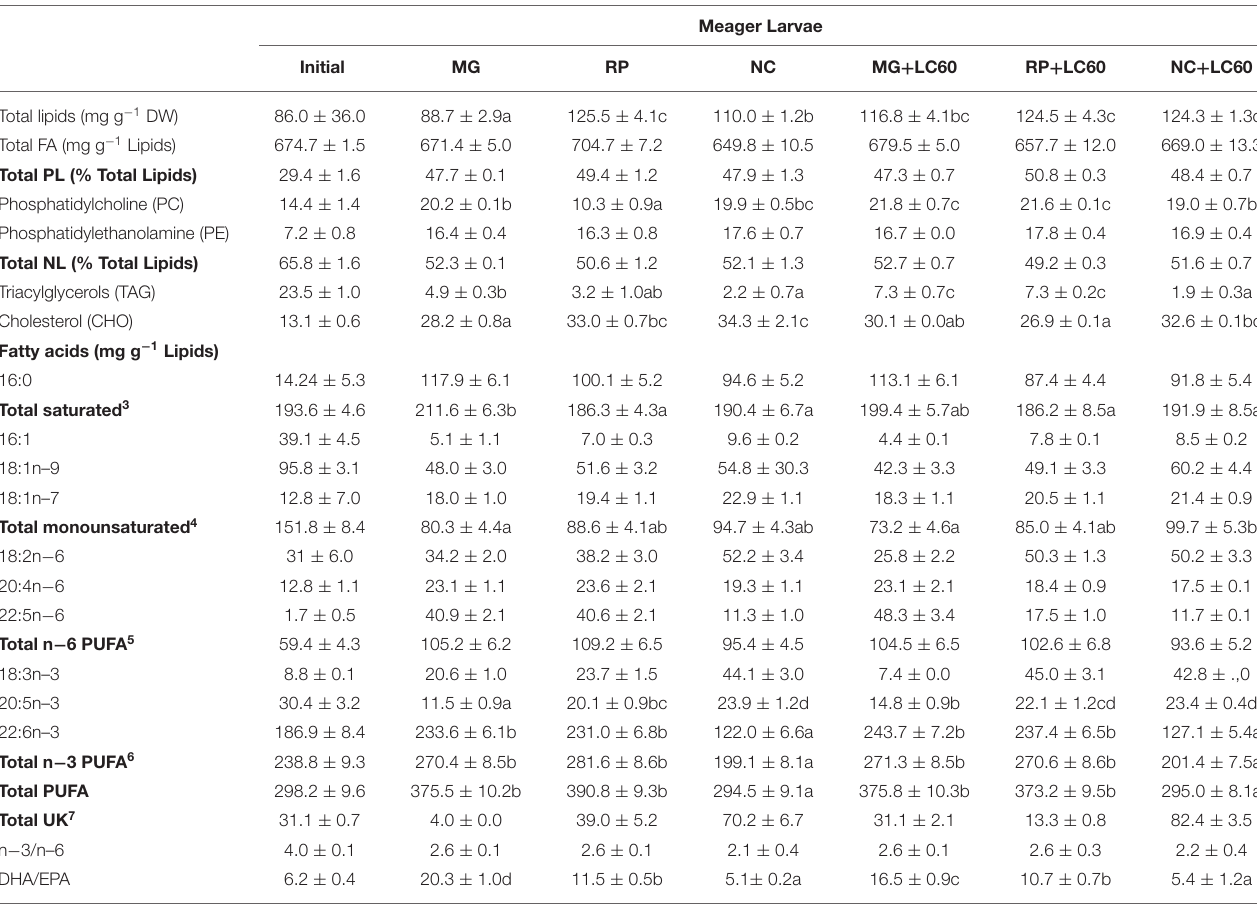
TABLE 4 | Total lipid and main lipid class content and fatty acid composition of 1 dph and 15 dph meager larvae fed rotifers enriched with Larviva Multigain (MG), Red Pepper (RP), Concentrated Nannochloropsis (NC), and marine phospholipids